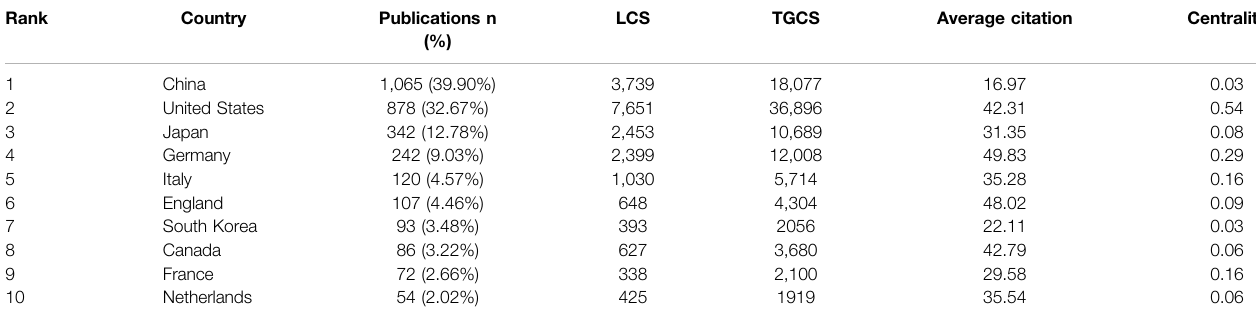
TABLE 1 | The top 10 productive countries concerning podocyte injury research. Rank